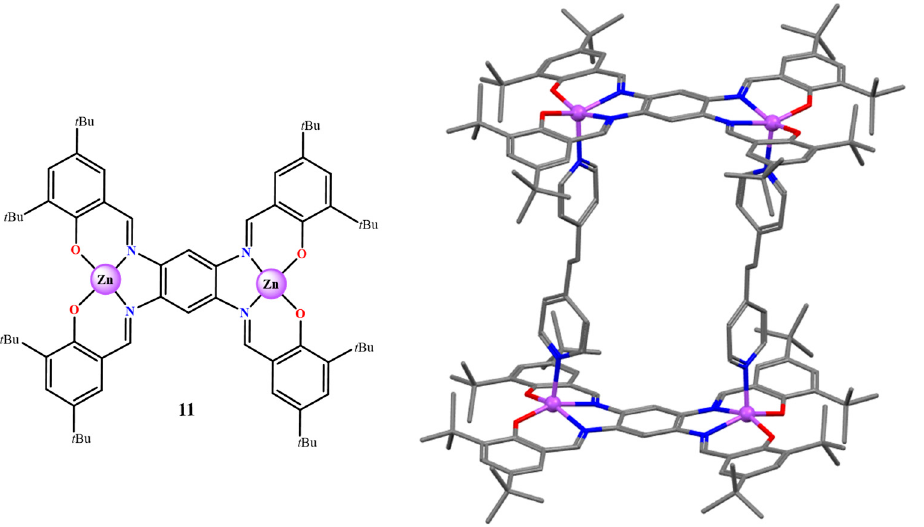
Figure 9. Molecular drawing of complex 11 ( left ) and crystal structure of the assembly of ( 11 ) 2 · (bipy) 2 in the solid state ( right ). Adapted from Ref. [46].